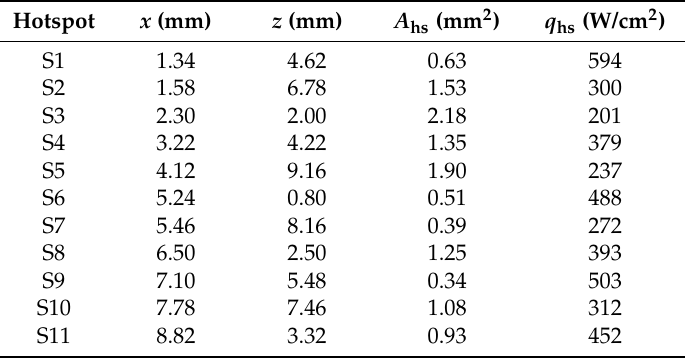
Table 5. Hotspots for the HS3